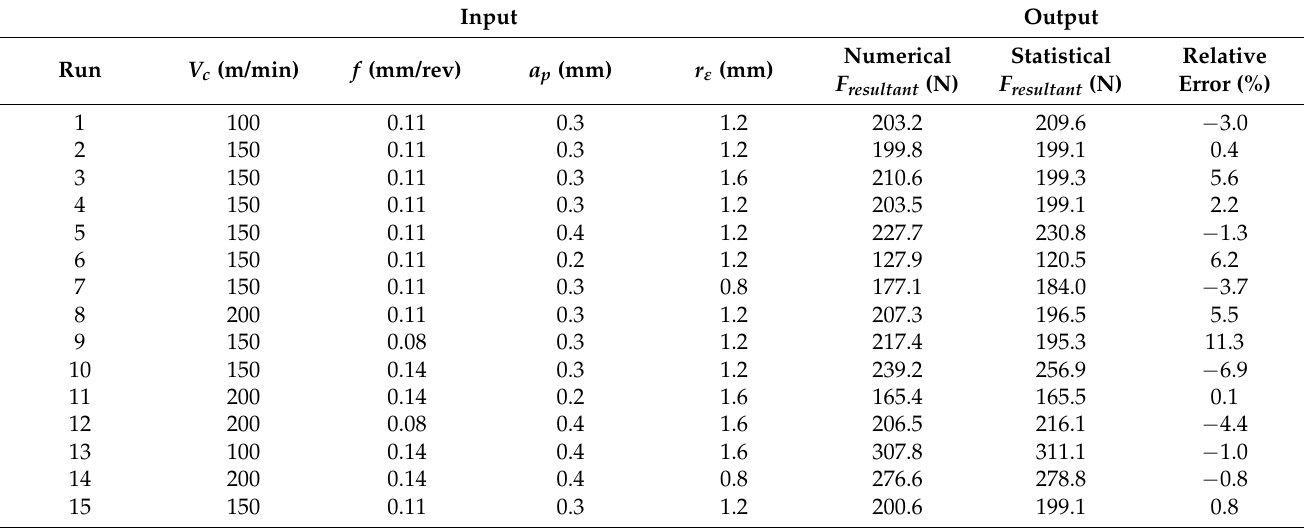
Table 4. Finite Element model run, results and comparison with statistical